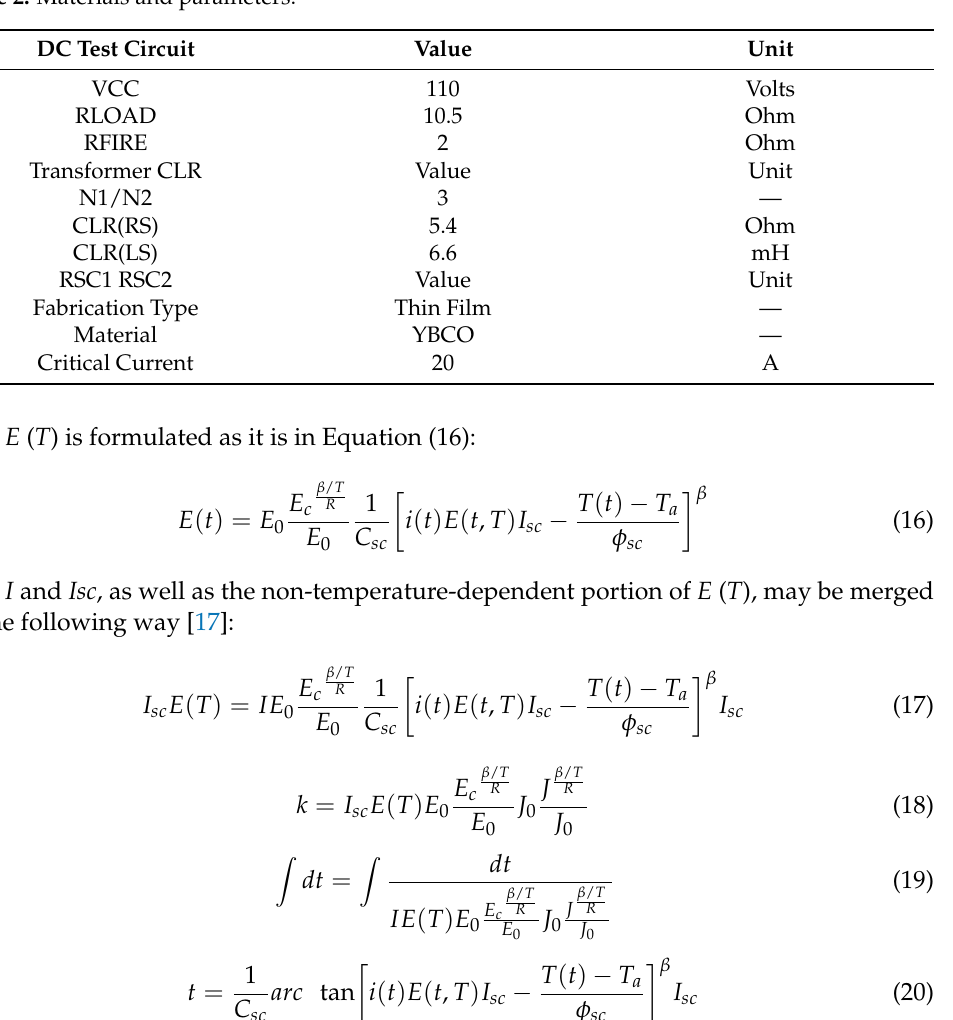
Table 2. Materials and